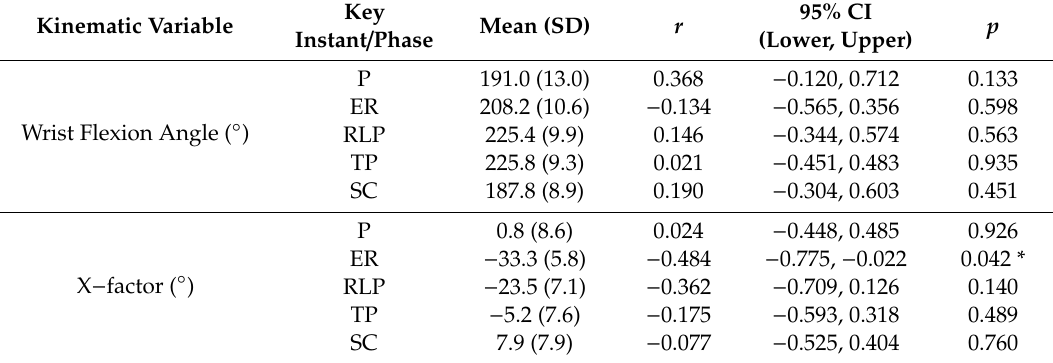
Table 4. Pearson product moment correlation (r) between joint angles of the wrist and X-factor at key instants and shuttlecock speed.